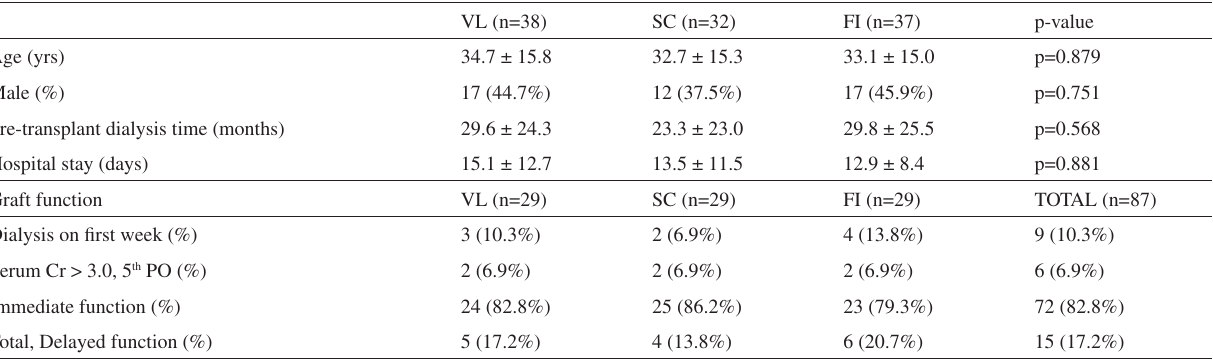
Table 2 - Recipient demographics and graft